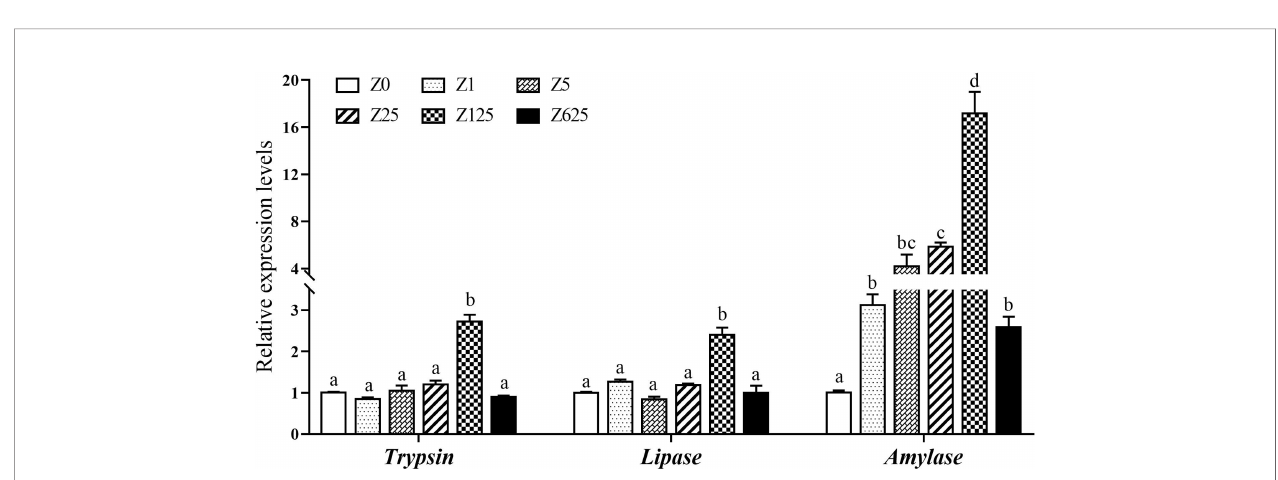
FIGURE 3 | Effect of different levels of zymosan-A on the activities of trypsin (A) , lipase (B) , and amylase (C) in the intestine of Litopenaeus vannamei . Different letters indicate signi fi cant differences between treatments ( p < 0.05).